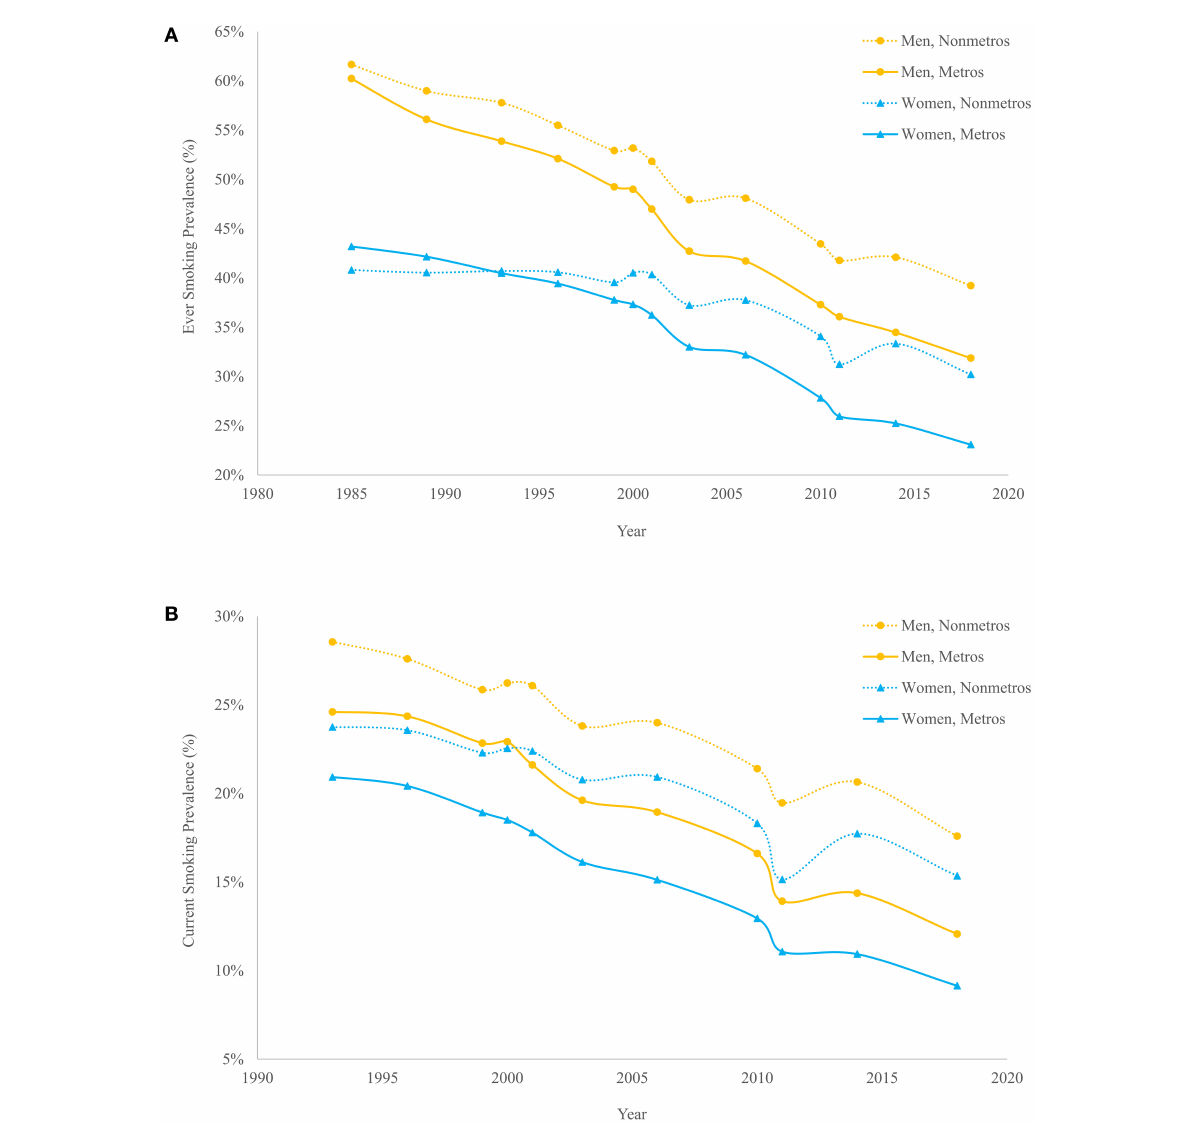
FIGURE1 Ever smoking (A) and current smoking (B) prevalence by metropolitan status and sex, 1985–2018. Estimates are authors’ calculations based on Current Population Survey Tobacco Use Supplements, 1985–2018. All estimates are based on the population aged 18 and older and are standardized to the 2000U.S. population age